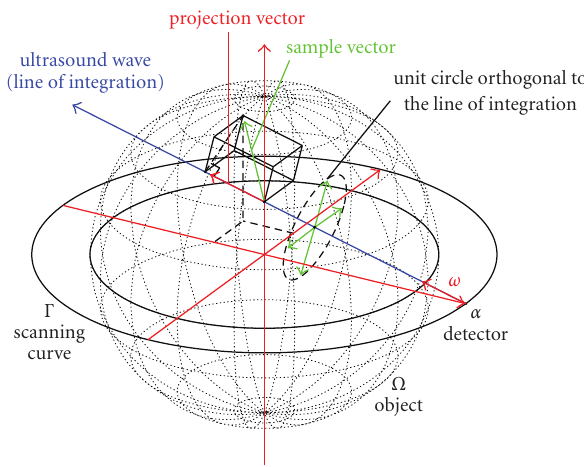
Figure 2: Visualization of the measured projection data for D 1 f